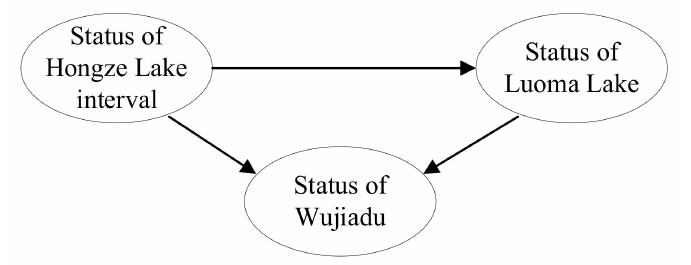
Figure 10. The Bayesian network